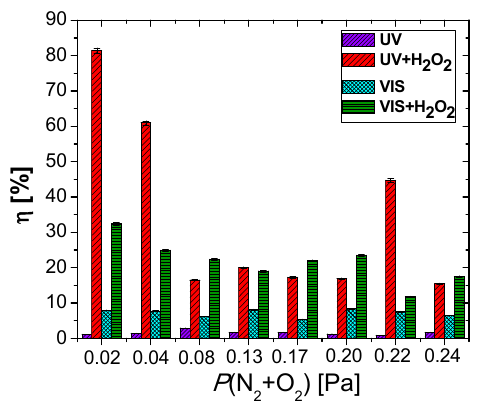
Figure 11. Variation of the photodegradation efficiency at equilibrium for the tantalum oxynitride thin films as a function of the partial pressure of the reactive gas.